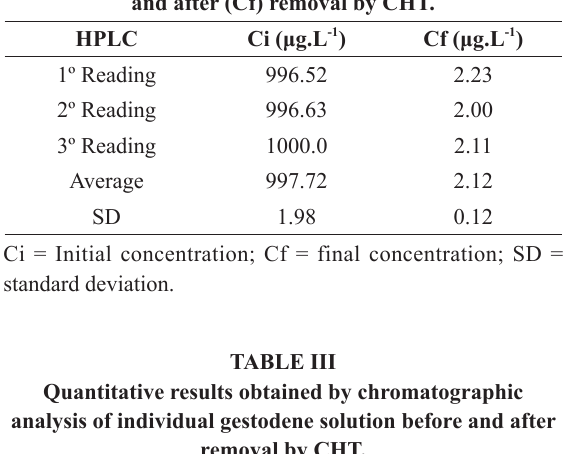
together in solution, obtained were 99.4% for